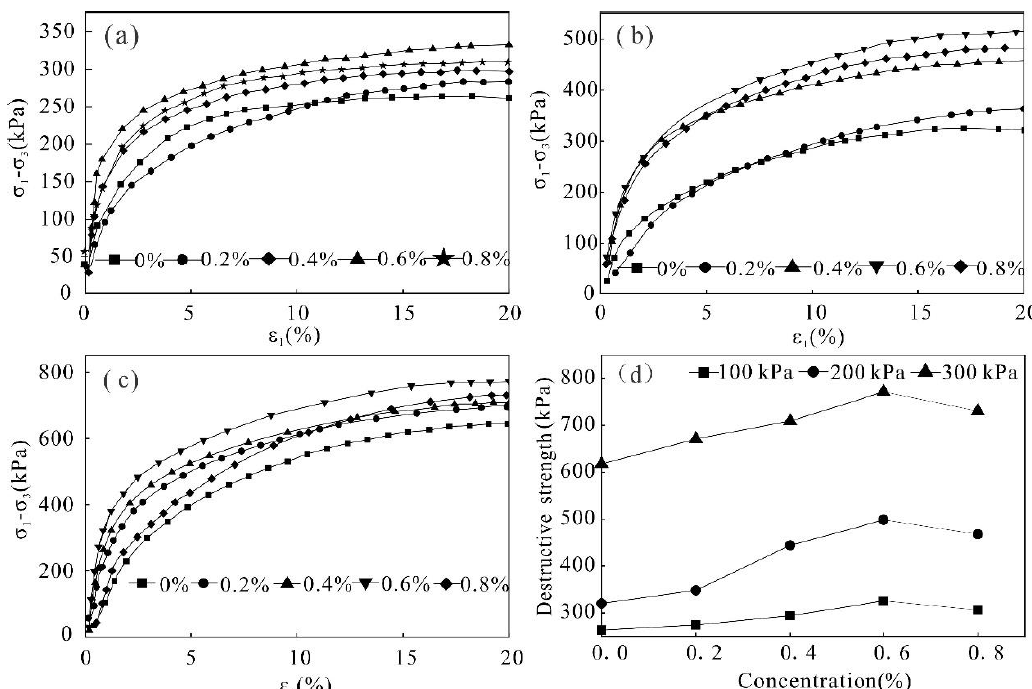
Figure 8. Triaxial compression test curve: ( a ) confining pressure of 100 kPa ( b ) confining pressure of 200 kPa ( c ) confining pressure of 300 kPa and ( d ) destructive strength.